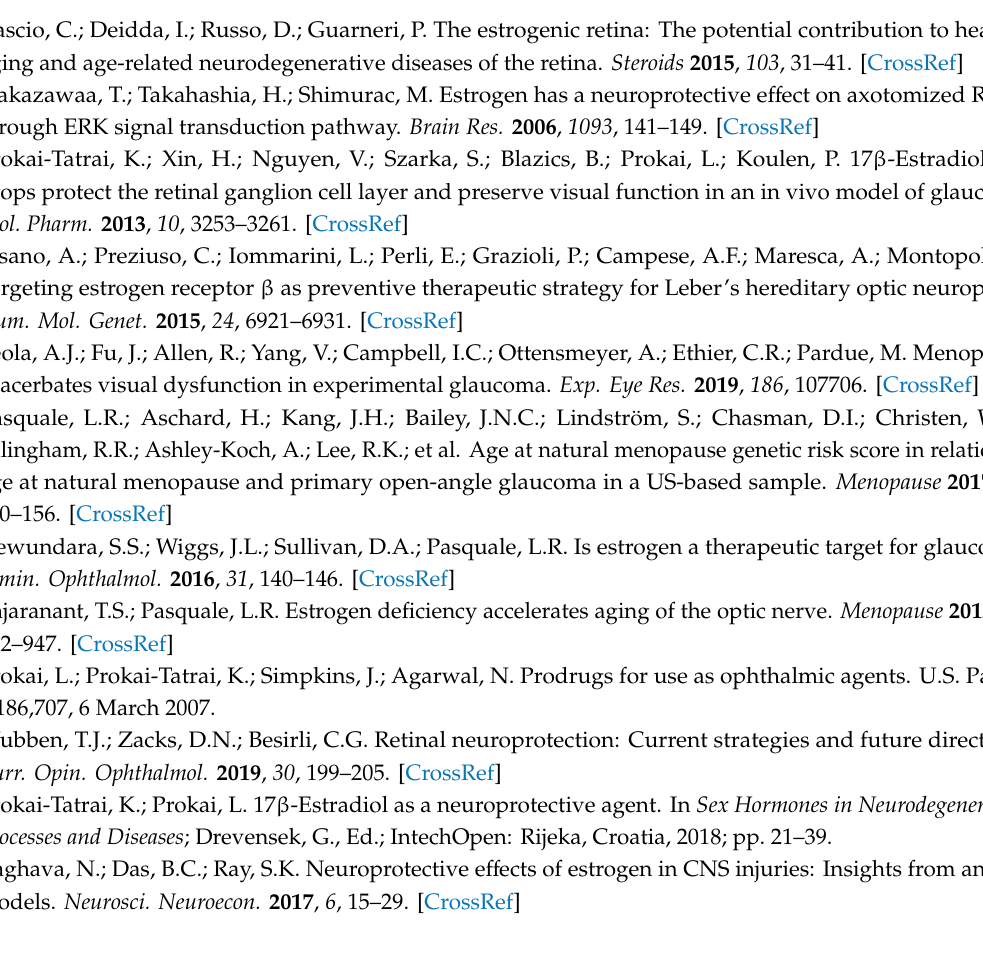
Table S1: 2 × 2 × 3 factorial ANOVA of ex vivo steady-state transcorneal fluxes (J ss ) listed in Table 1; Figure S1: In vitro studies on DHED to E2 metabolism; Figure S2: Neuroprotective e ff ect of DHED-derived E2 on visual function measured as contrast sensitivity at a given spatial frequency in a rat model of